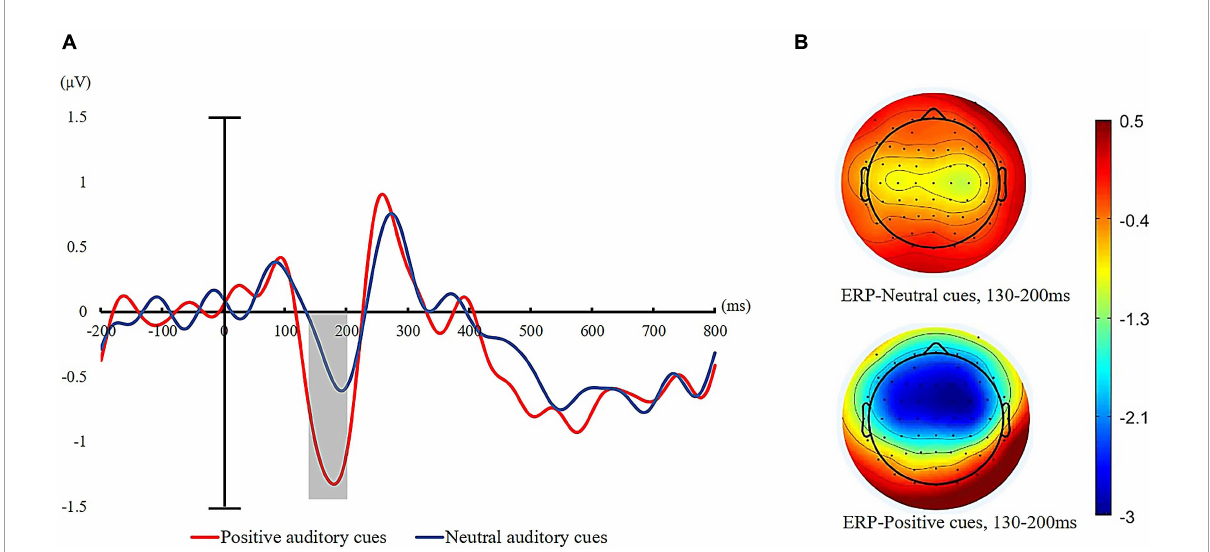
FIGURE4 (A) ERPs recorded to the different emotional auditory cues (neutral = blue line and positive = red line) averaged across all participants. (B) Topographic maps for the different auditory cues at the mean peak of the N1 component (130–165 ms after the onset of auditory